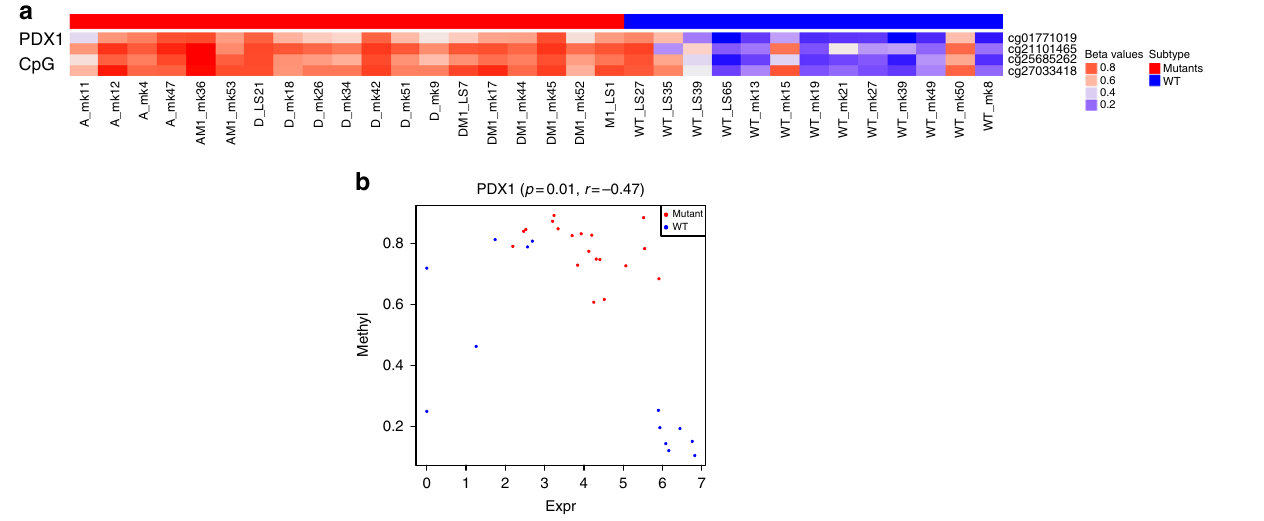
Fig. 7 PDX1 has promoter hypermethylated and lower gene expression in A-D-M mutant panNETs. a Four PDX1 promoter CpG sites show strong hypermethylation in A-D-M mutant PanNETs (corrected p -val < 0.05, Benjamini – Hochberg). The range of beta values is from 0 to 1 and represented as blue (hypo-methylation) to red (hyper-methylation). b PDX1 expression and promoter methylation (TSS1500 cg27033418 CpG site) across all samples showing separation of A-D-M mutant and A-D-M WT